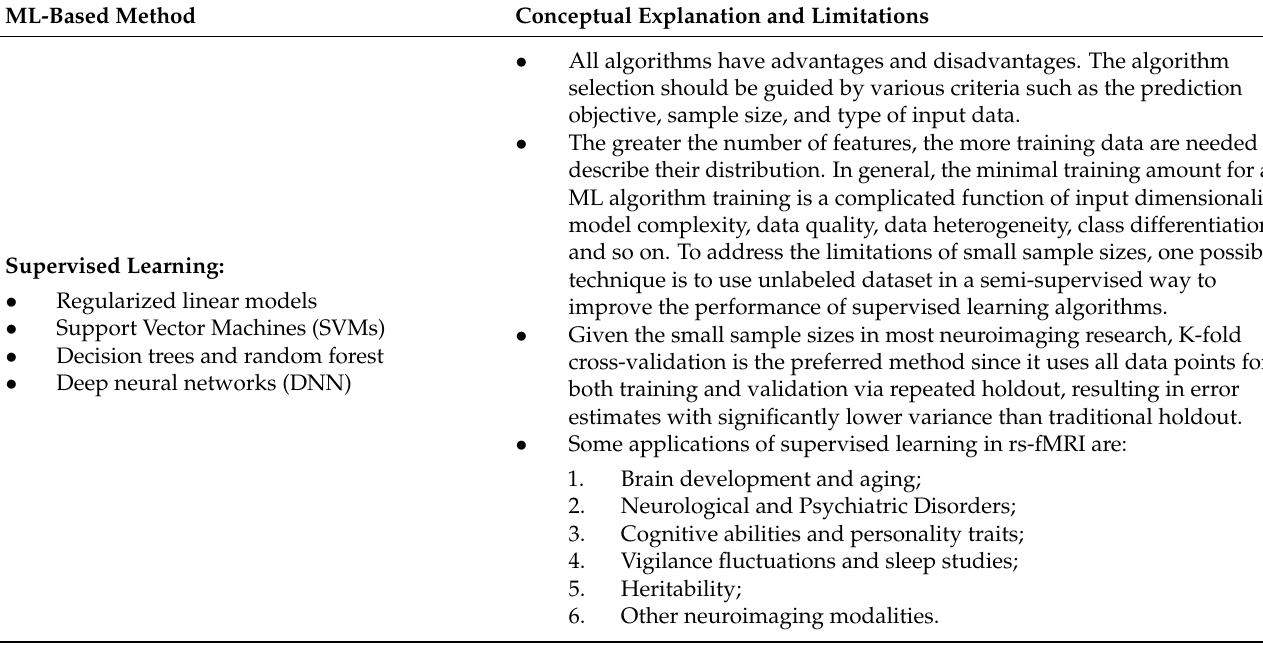
Table 2. ML-based methods for functional connectivity